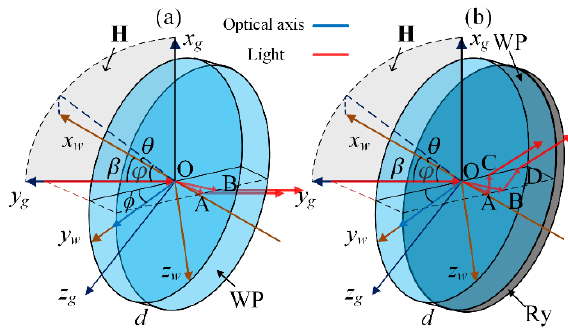
Figure 2. Schematic of the light propagation in the waveplate under arbitrary attitude angles, x w - y w - z w is the coordinate system of the waveplate, x g - y g - z g is the coordinate system of the ground. H is the horizontal plane, which is composed of the x g - y g axis. The ϕ refers to the azimuth of the incident plane with respect to the optical axis, which also represents the roll. The β refers the incident angle of the input light. The angle between x w axis and the projection of x w on the H plane is the pitch θ , and the angle between the projection and y g axis is the yaw φ . WP is the transmission mode; (b) the reflection